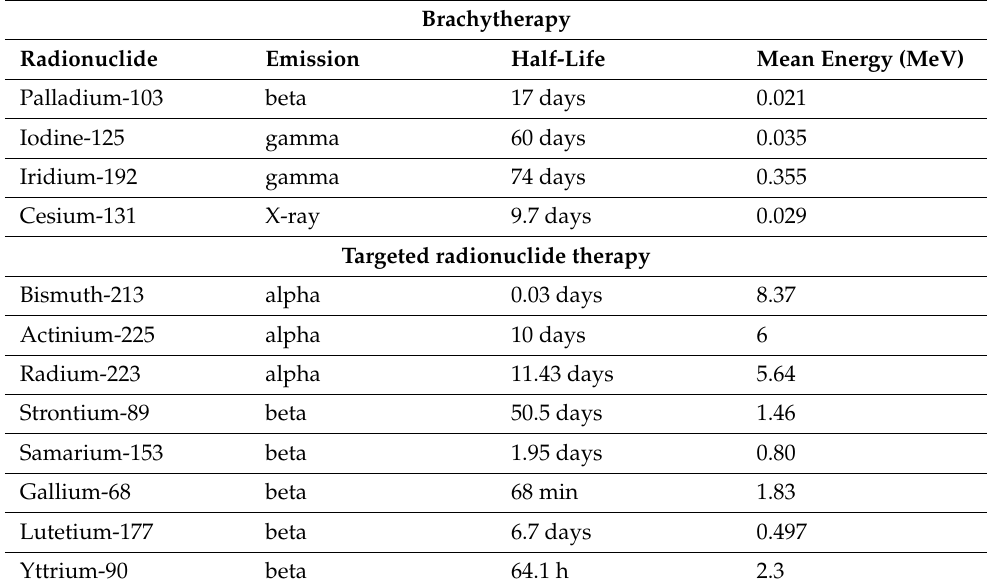
Table 1. Physical characteristics of radionuclides commonly used in brachytherapy and targeted radionuclide therapy for prostate cancer.